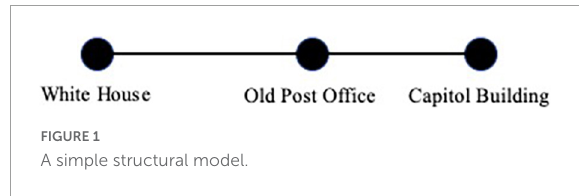
FIGURE1 A simple structural